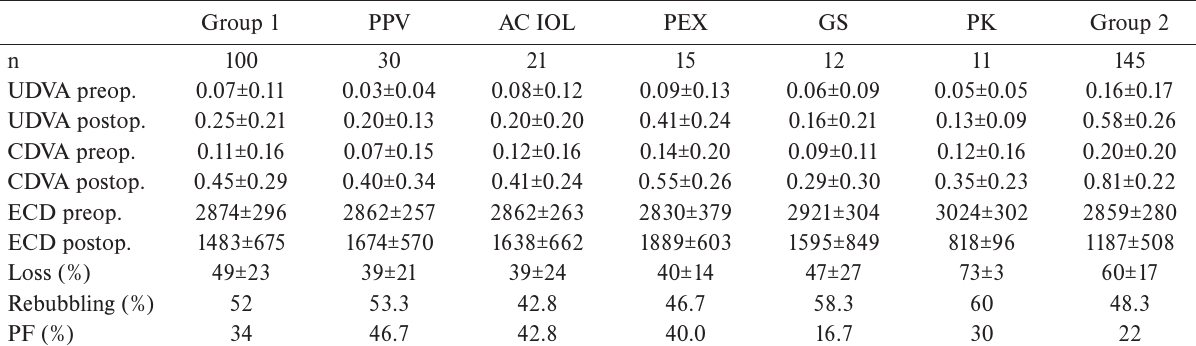
Table 2. Comparison of results preoperatively and 12 months after